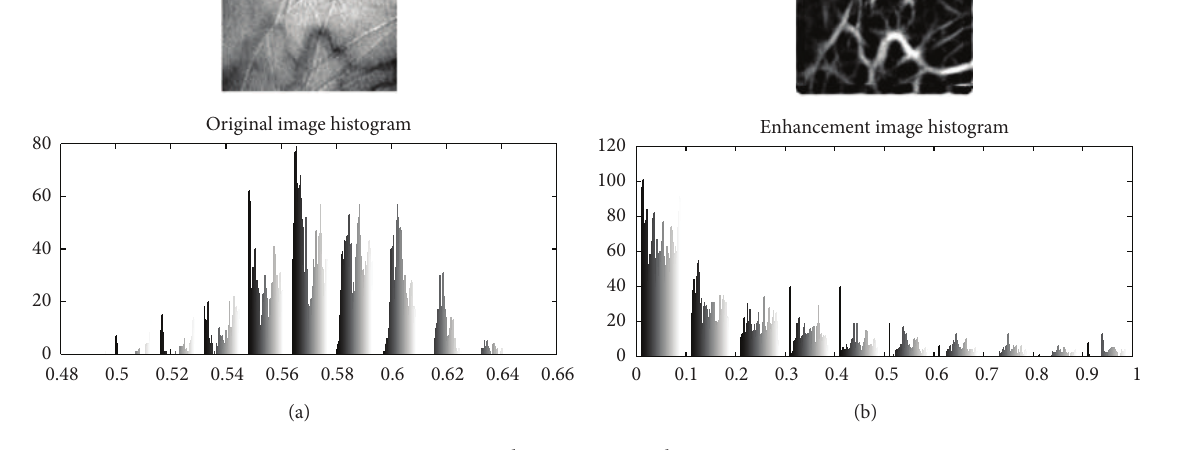
Figure 2: Palm vein image enhancements.